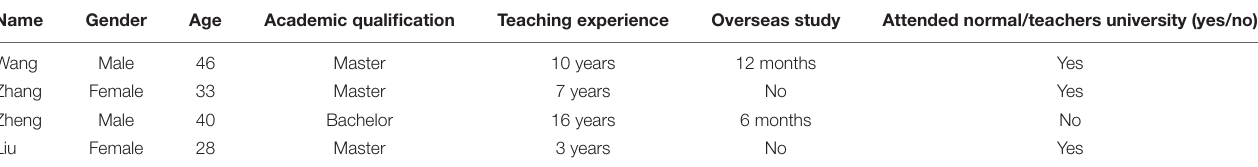
TABLE 1 | Participants’ demographic